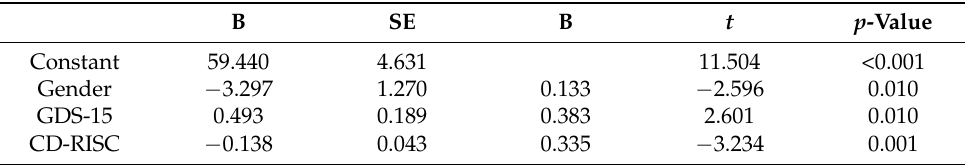
Table 3. Regression analysis of influencing factors of alexithymia.